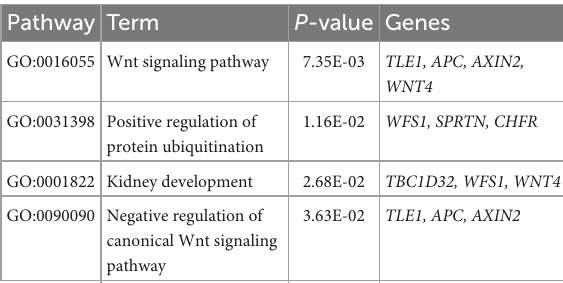
Genome-wide association study results with additional covariates of grip strength and muscle mass are provided in Supplementary Table 3 . Chr, chromosome; Bp, physical position; A1, minor allele; A2, major allele; Freq, frequency of the minor allele; b, SNP effect;Se,standarderror; P , P -value. TABLE 2 The significant gene ontology terms ( P < 0.05) enriched from 60 genes putatively associated with vascular endothelial function.